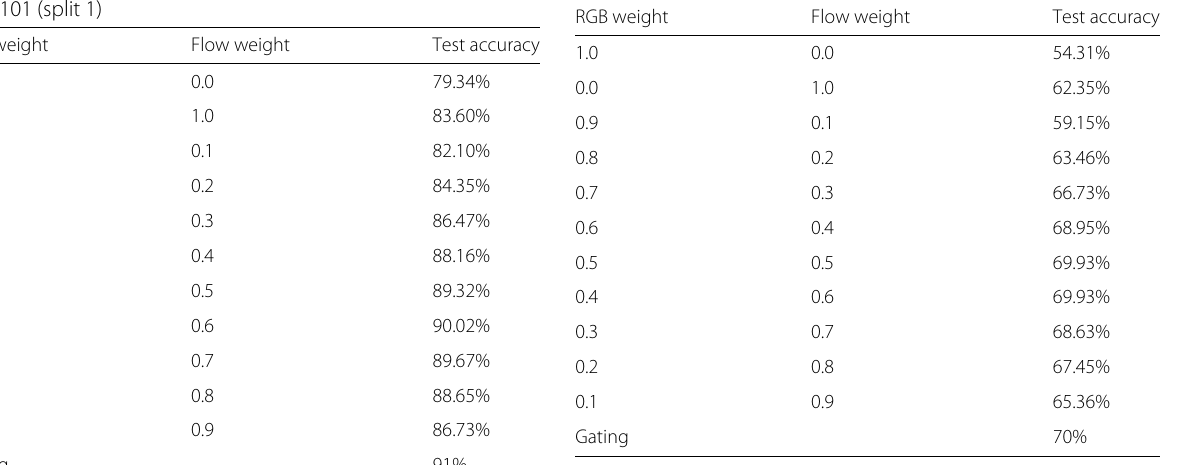
Table 9 Gated temporal segment network on HMDB-51 (split